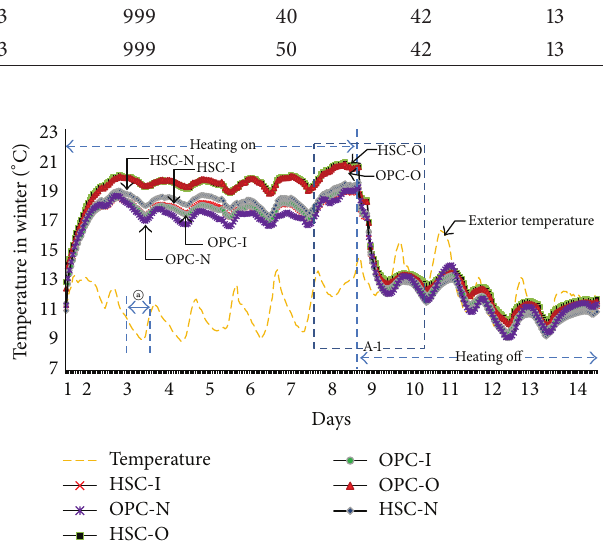
Figure 3: Result of the measurement of temperature of the interior of the specimen in